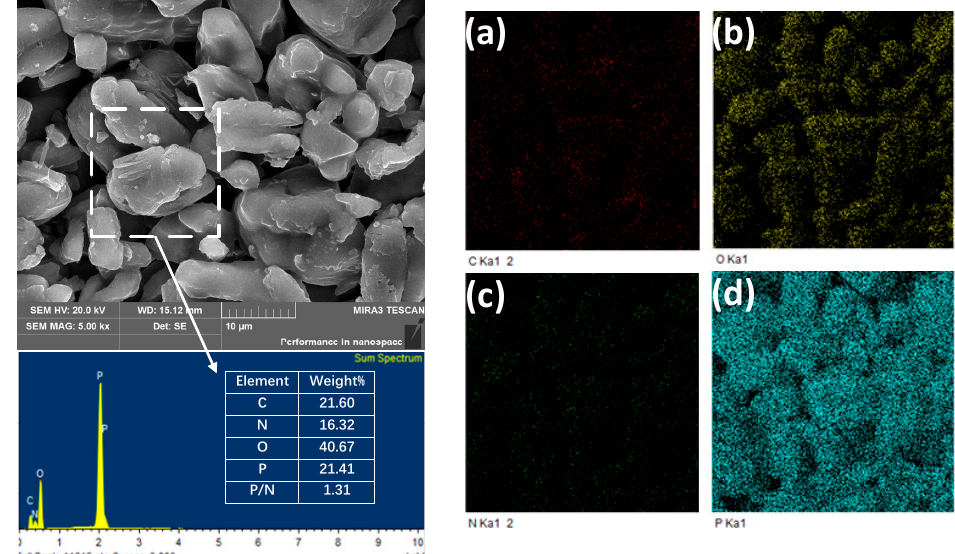
Figure 4. SEM images and EDS maps of DDP flame retardant ( a ) carbon, ( b ) oxygen, ( c ) nitrogen, and ( d ) phosphorus.